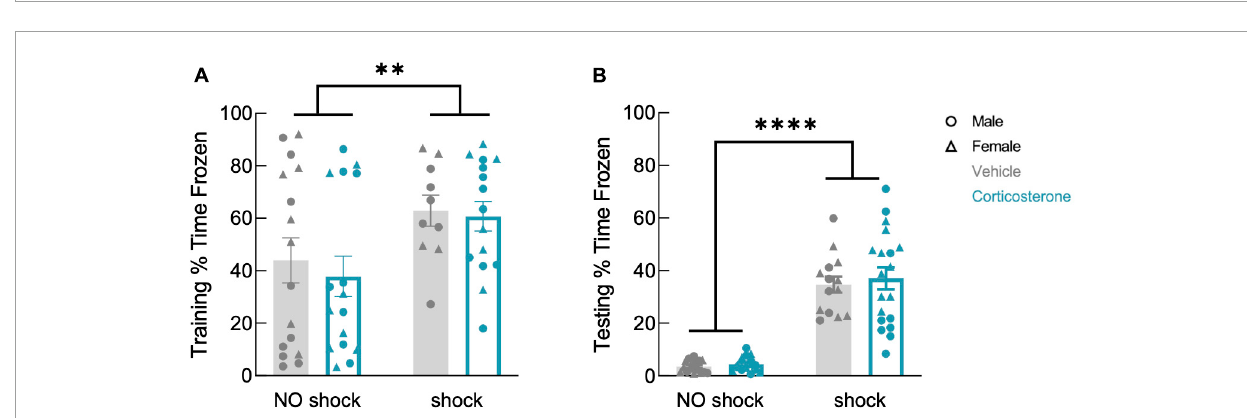
FIGURE4 History of footshock, but not corticosterone administration, affected contextual fear memory. Animals that had experienced shocks from more than control animals in both (A) training and (B) testing trials, while corticosterone-treated and vehicle-treated animals froze at equal rates (training: no shock N = 32, shock N = 25; testing: no shock N = 32, shock N = 33). ∗∗ P < 0.01; ∗∗∗∗ P <